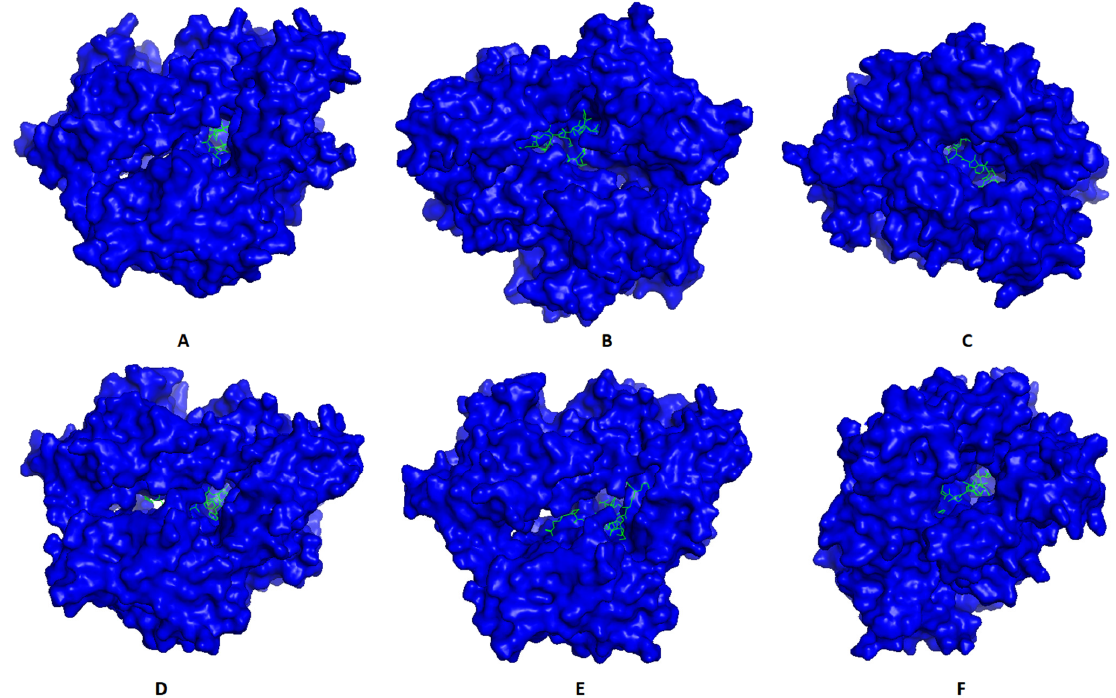
Figure 3. Structural positions of MHC-II epitopes (green color) in three-dimensional structure of HLA-DRB1*04:01 (blue color); structures A, B, C, D, E , and F are for epitopes numbers 1, 2, 3, 4, 5, and 6, respectively, from Table